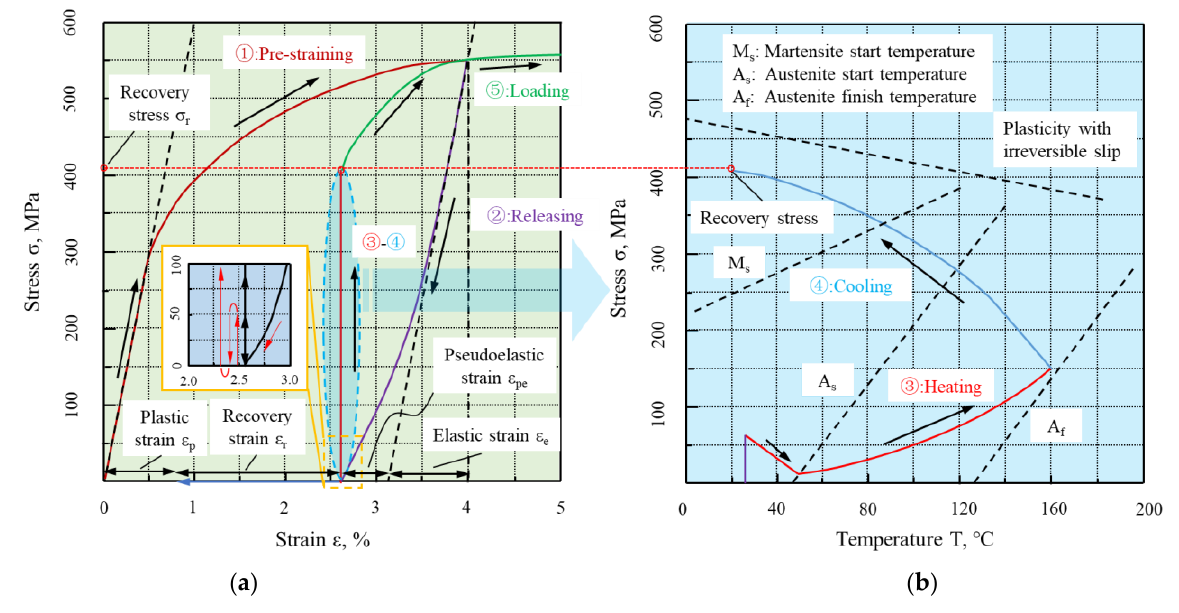
Figure 6. Schematic diagram of Fe-SMAs generating recovery stress (adapted from [90,91]): ( a ) stress – strain curve; ( b ) stress – temperature curve.